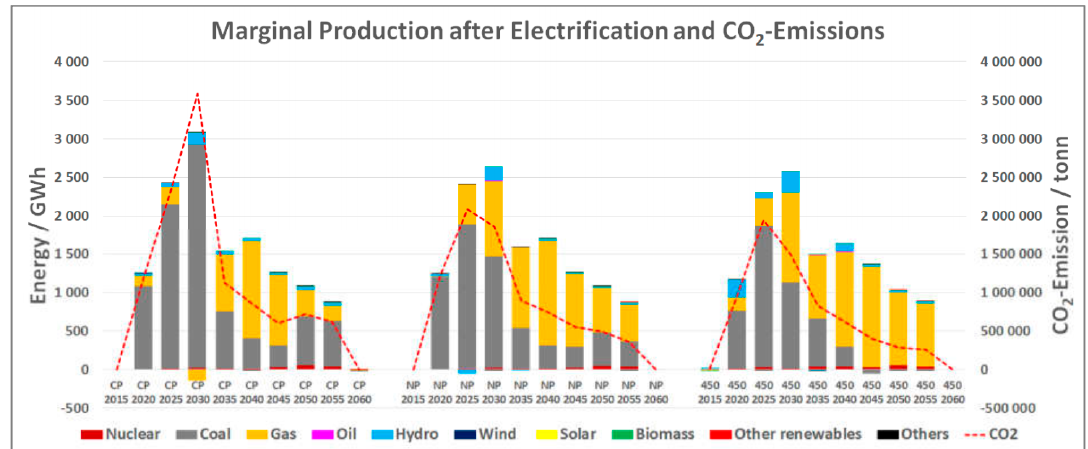
Figure 10. Comparison of the marginal generation of all results after the electrification.